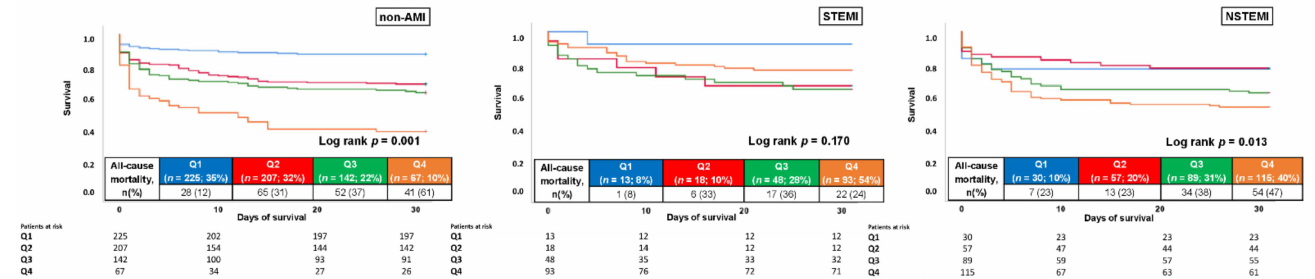
Figure 6. Kaplan–Meier analysis for cTNI with regard to 30-day all-cause mortality (primary end- point), stratified by the presence or absence of